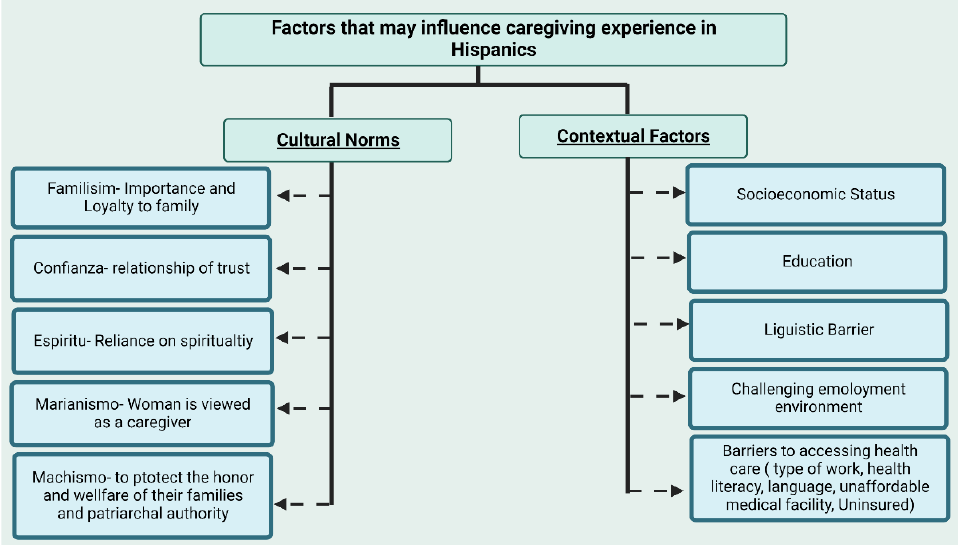
Figure 6. Cultural and contextual factors that may influence caregiving practices in the Hispanic population.